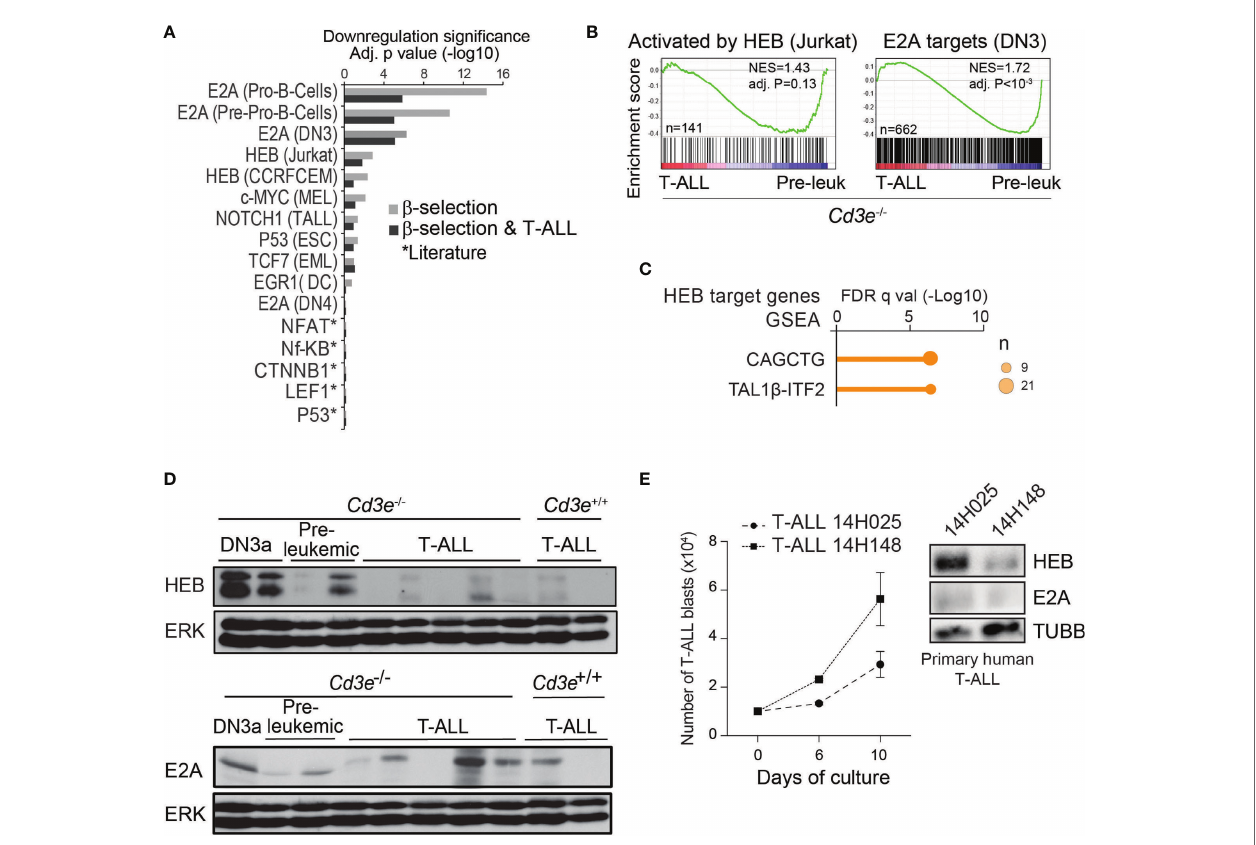
FIGURE 2 | T-ALL progression associated with an inhibition of E proteins targets and downregulation of HEB protein. (A) Regulator analysis identi fi ed transcription factors associated to transcriptional repression during T-ALL progression and b -selection. Regulators are rank-ordered according to their enrichment scores. The bars display the downregulation signi fi cance (log10 adjusted P, Fisher ’ s exact test). Targets were extracted from ChIP-seq datasets (cell types in parenthesis). (B) GSEA analysis of genes activated by HEB and E2A targets during progression from pre-leukemic to leukemic state in Cd3e -de fi cient SCL tg LMO1 tg T-ALL. (C) Binding site motif enrichment (MSig) within the proximal promoter regions of HEB target genes down-regulated between Cd3e -/- leukemic and pre-leukemic cells. (D) HEB and E2A protein levels during T-ALL progression measured by Western blotting. (E) Growth in vitro for primary T ‐ ALL samples (left panel). Western blot analysis of theindicated T-ALL samples (right